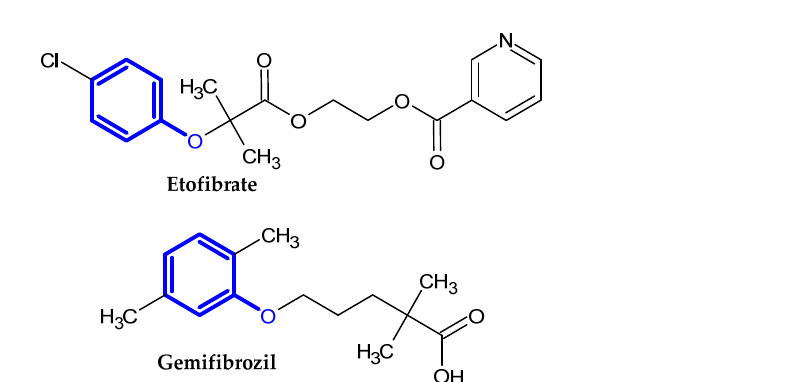
Figure 6. Antimicrobial drugs.